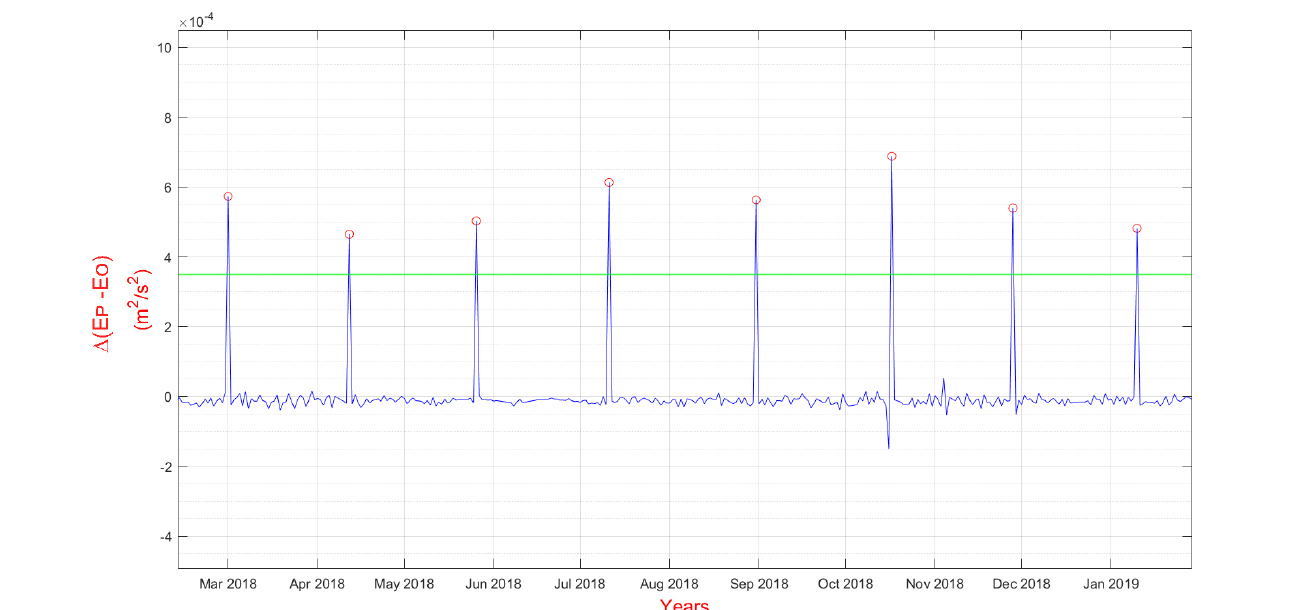
Figure 8. Baseline Case for TDRS-3. The red circles represent potential maneuvers detected by this method.